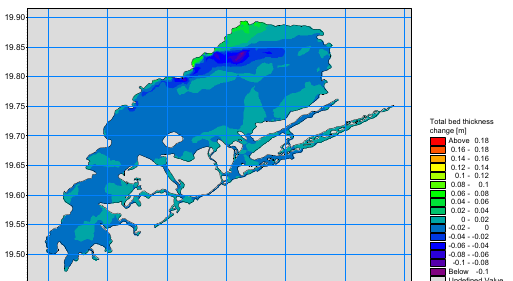
Figure 7f. Simulated spatial profile of Total bed thickness